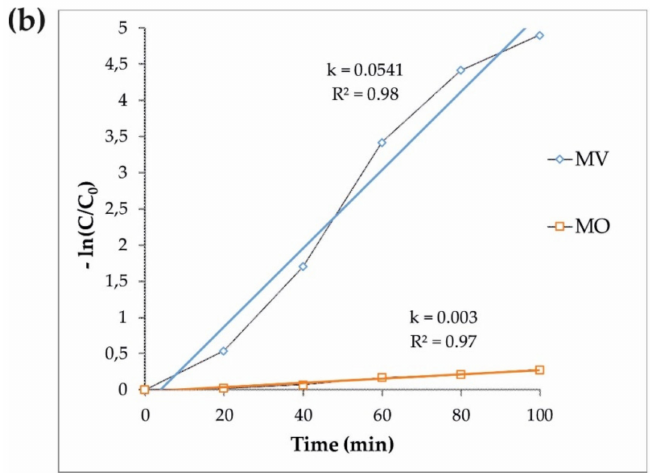
Figure 6. ( a ) The photocatalytic degradation of the MV and MO pollutants by the S4 sample under visible light assisted by H 2 O 2 , and ( b ) the pseudo-first-order kinetics of the MV and MO degradation by S4.